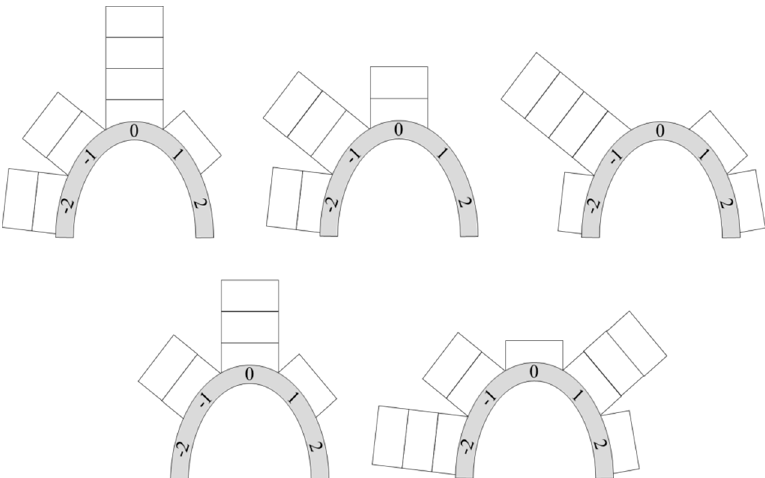
Figure 4. Distribution of participants during the ‘Living Q’ session in Poole. Each distribution represents a sub-group discussing statement no. 1.